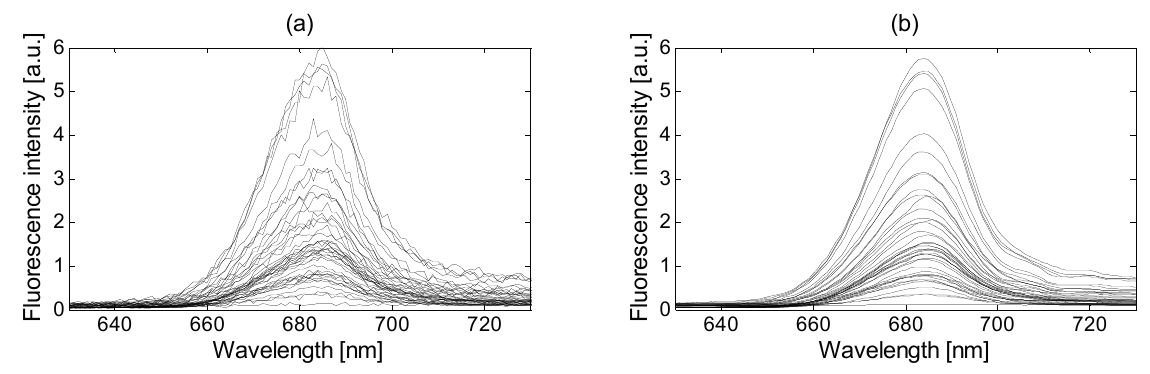
Figure 7. ( a ) Original and ( b ) smoothed spectra of all the Pl measurements obtained with the Savitzky-Golay method and (cid:1866) = 17